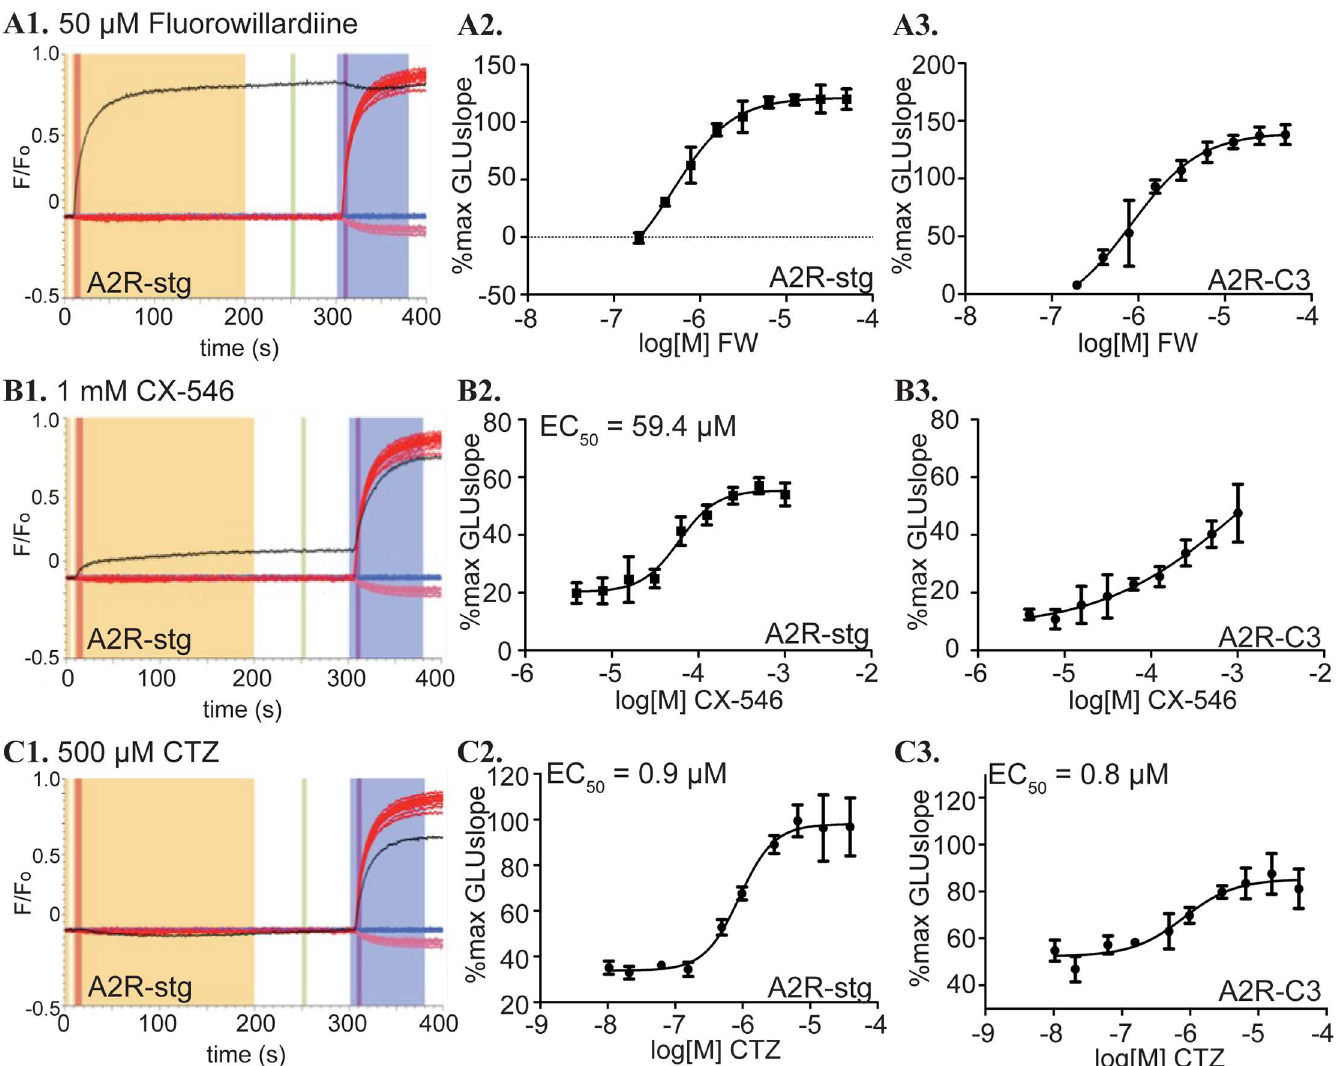
Fig 2. Behavior of established compounds in VSD assay. (A1) Normalized fluorescence data for VSD assay on A2R-stg cells with 50 μ M fluorowillardiine (black) with maxGLU (red) and NBQX (pink)controls, all normalizedto EC 50 GLU (blue). (A2) CRC curves for FW against A2-stg and ( A3) A2-C3 cell lines calculatedfrom the CMPDslope window.%max GLUslope= (CMPDslope—meanVHLslope)/(mean maxGLUslope—meanVHLslope) is further describedin methods. ( B1) Normalizedfluorescence data for VSD assay on A2R-stg cellswith 1 mM CX-546(black) with maxGLU (red) and NBQX (pink)controls, all normalizedto EC 50 GLU (blue). (B2) CRC curves for CX-546 againstA2R-stg and ( B3) A2R-C3cell lines calculatedfrom the GLUslopewindow.%max GLUslope= (GLUslope—mean VHLslope)/(mean maxGLUslope—meanVHLslope) (C1) Normalizedfluorescence data for VSD assay on A2R-stg cells with 500 μ M cyclothiazide (CTZ, black) with maxGLU (red) and NBQX (pink), all normalized to EC 50 GLU (blue). (C2) CRC curves for CTZ againstA2-stg and (C3) A2-C3 cell lines calculated from the GLUslopewindow.CompoundEC 50 valuesthat couldbe reliablycalculatedare in the top left corner of each graph.